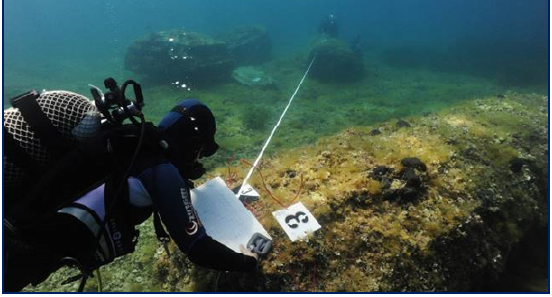
Figure 2. Survey by trilateration of CPs and